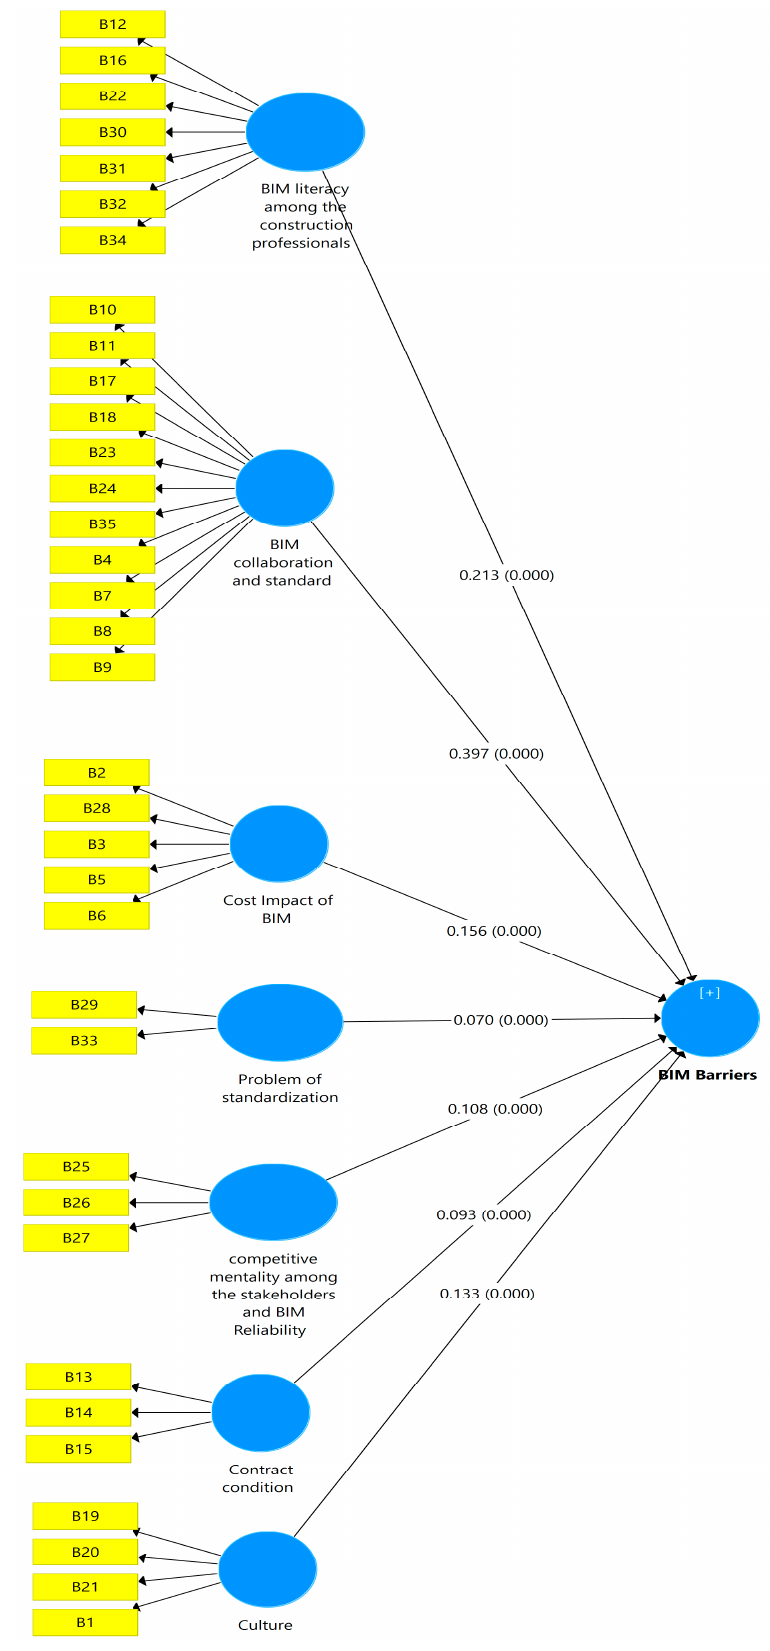
Figure 3. Path analysis.